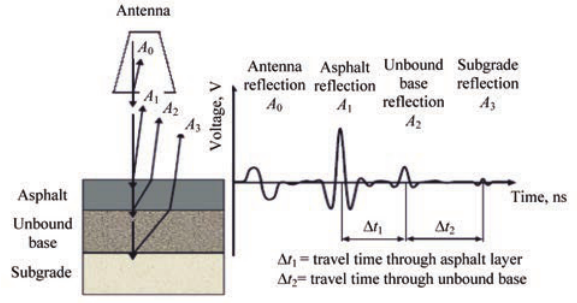
Fig. 2. Electromagnetic wave transmitted to the pavement